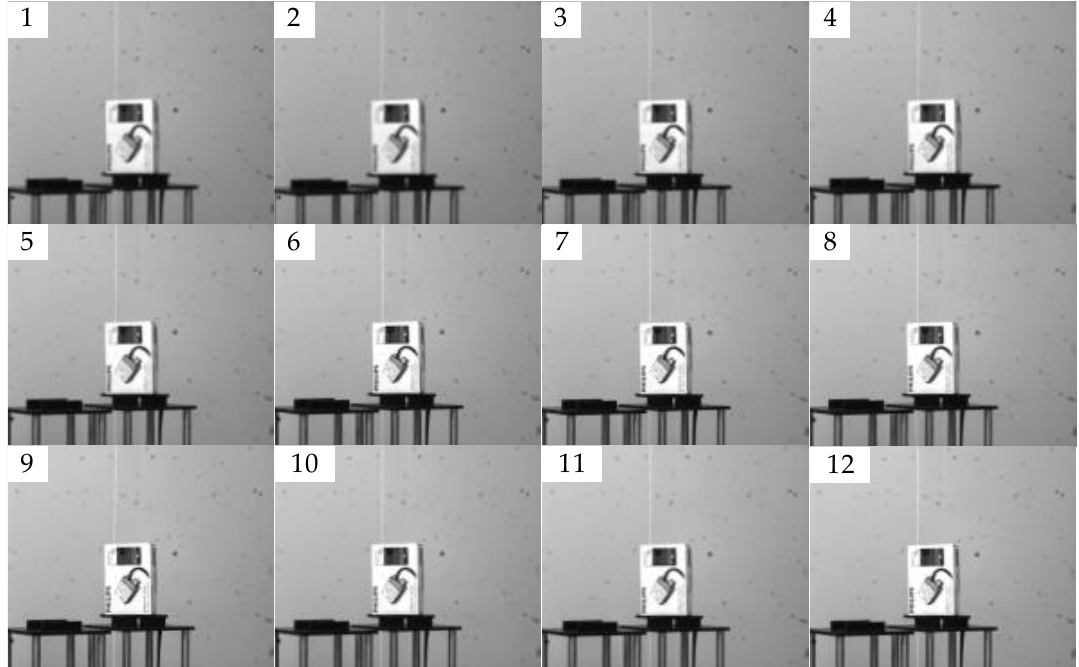
Figure 2. Indoor defocused image sequence. Sub-figures (1 – 12) represent the imaging results of the laboratory imaging system for the same target. The shooting process is from defocus to focus and back to defocus. The 9th picture shows the focus state.